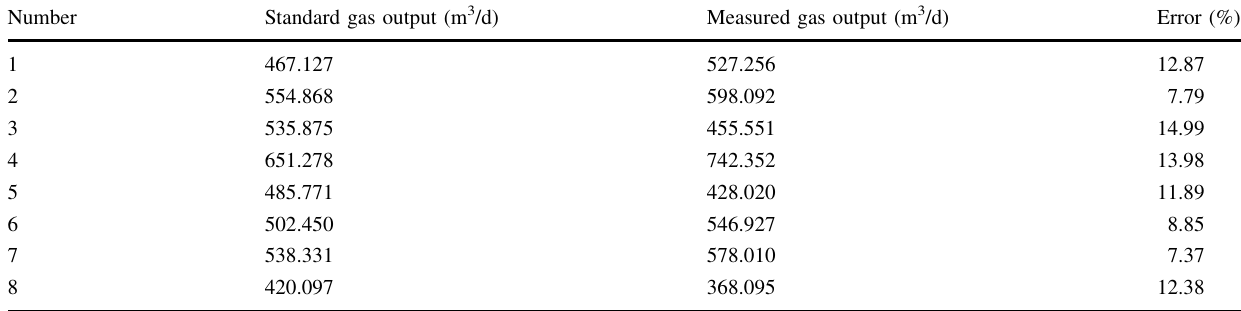
Table 4 Field test data summary